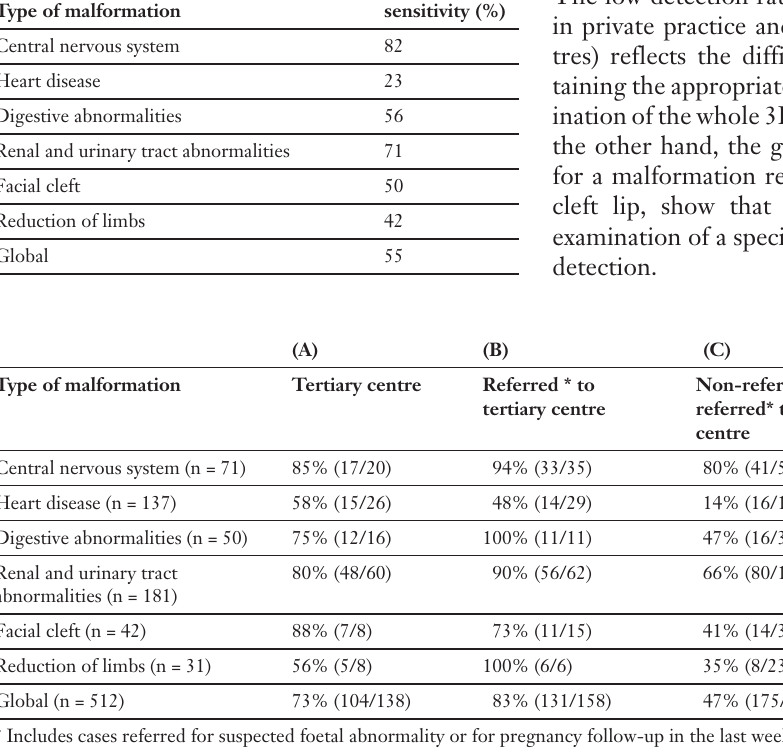
Sensitivity of screen- ing in the Canton of Vaud.